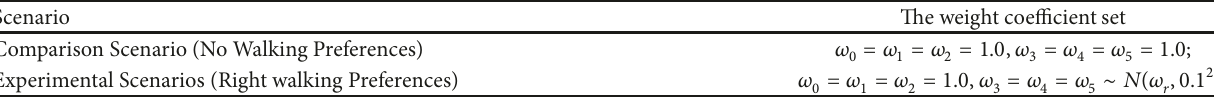
Table 5: Weight coefficient set in each scenario.